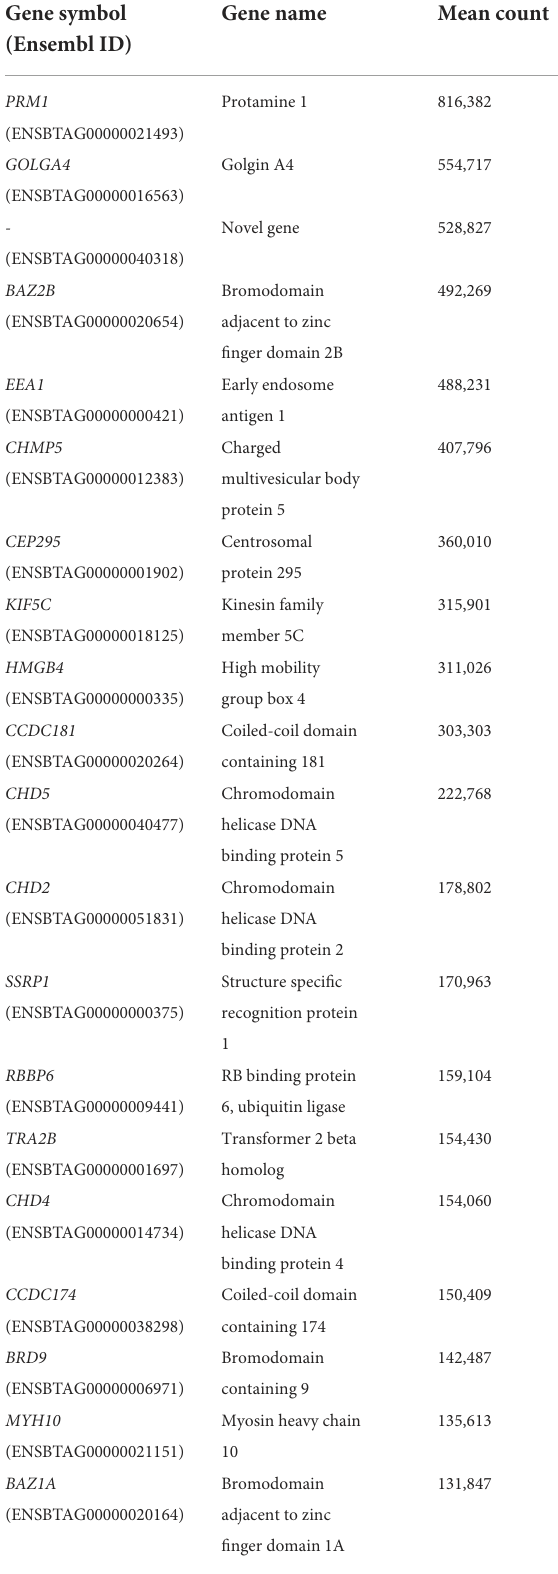
TABLE 2 List of the 20 most highly expressed